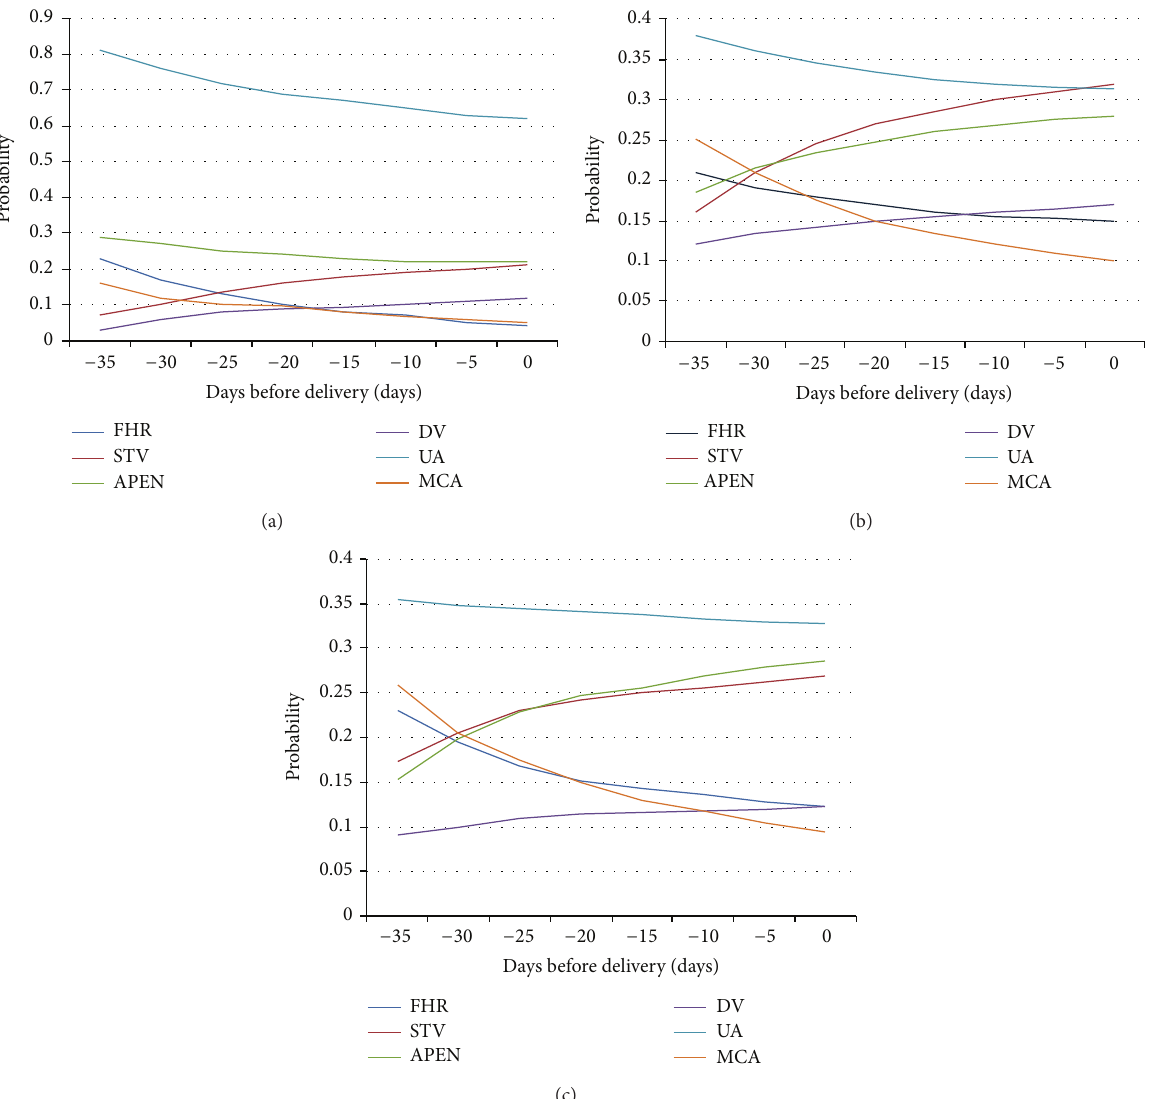
Figure 2: Probabilities of abnormal findings of variables in relation to time before delivery for (a) fetuses delivered before the 34th week of gestation. (b) Fetuses delivered between 34th and 37th week of gestation. (c) Fetuses delivered after the 37th week of